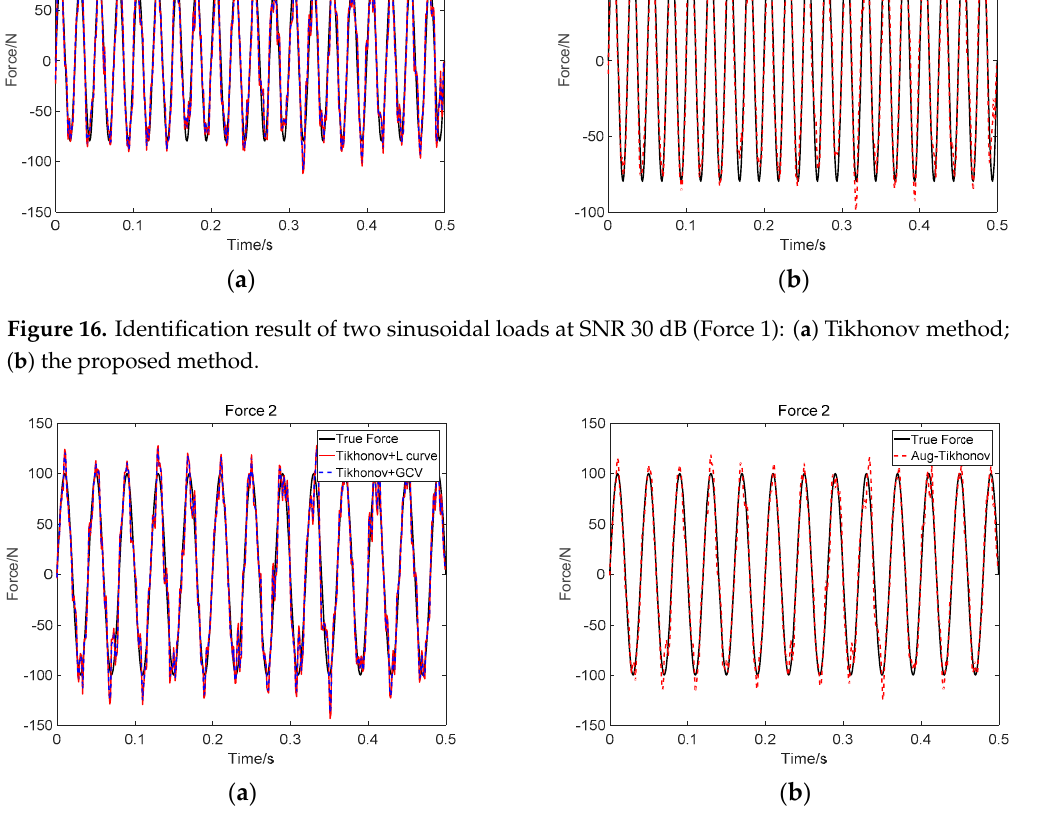
Figure 17. Identification result of two sinusoidal loads at SNR 30 dB (Force 2): ( a ) Tikhonov method; ( b ) the proposed method.